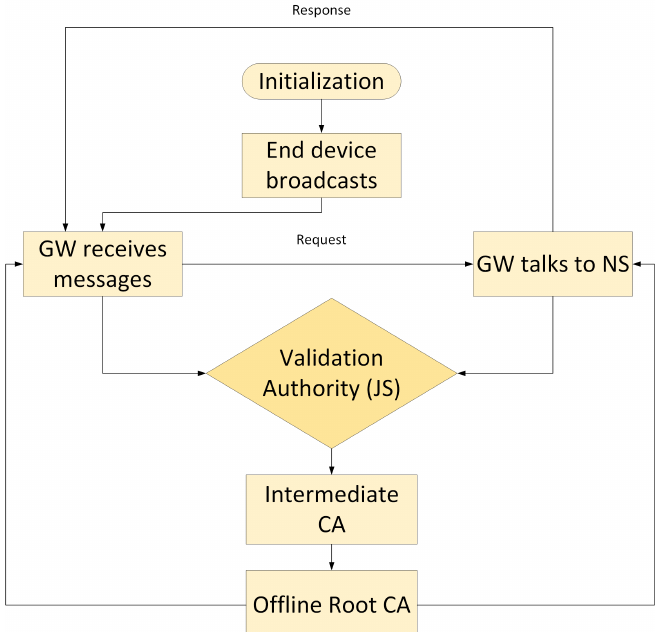
Figure 8. Flow chart of the certification process in the proposed